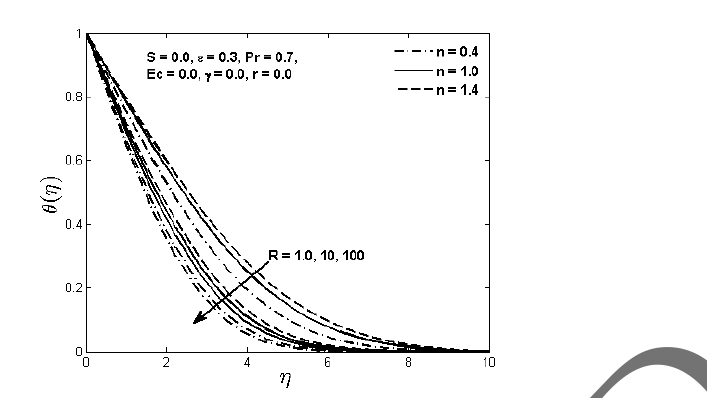
Figure 5. Temperature profiles for various values of R and n